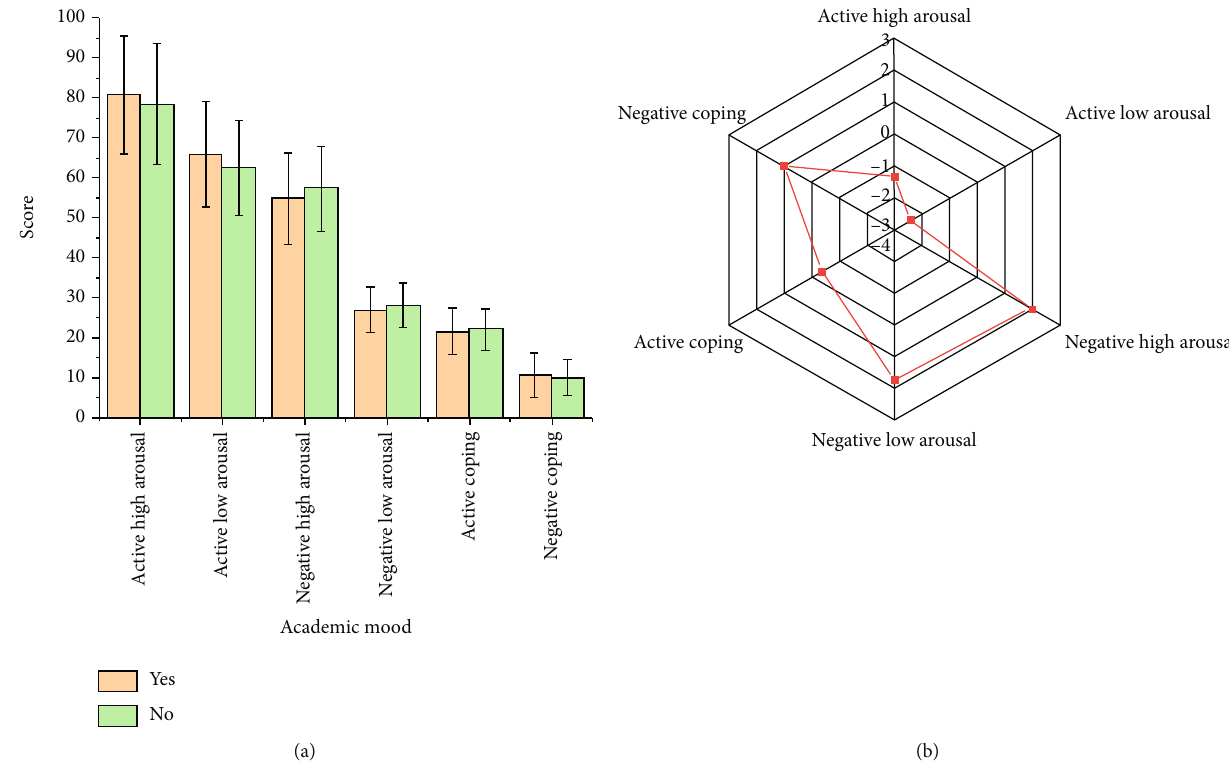
Figure 8: Di ff erences in academic emotions and coping styles of art students who are the only children or not ((a) score statistics for each dimension and (b) t -test results for each